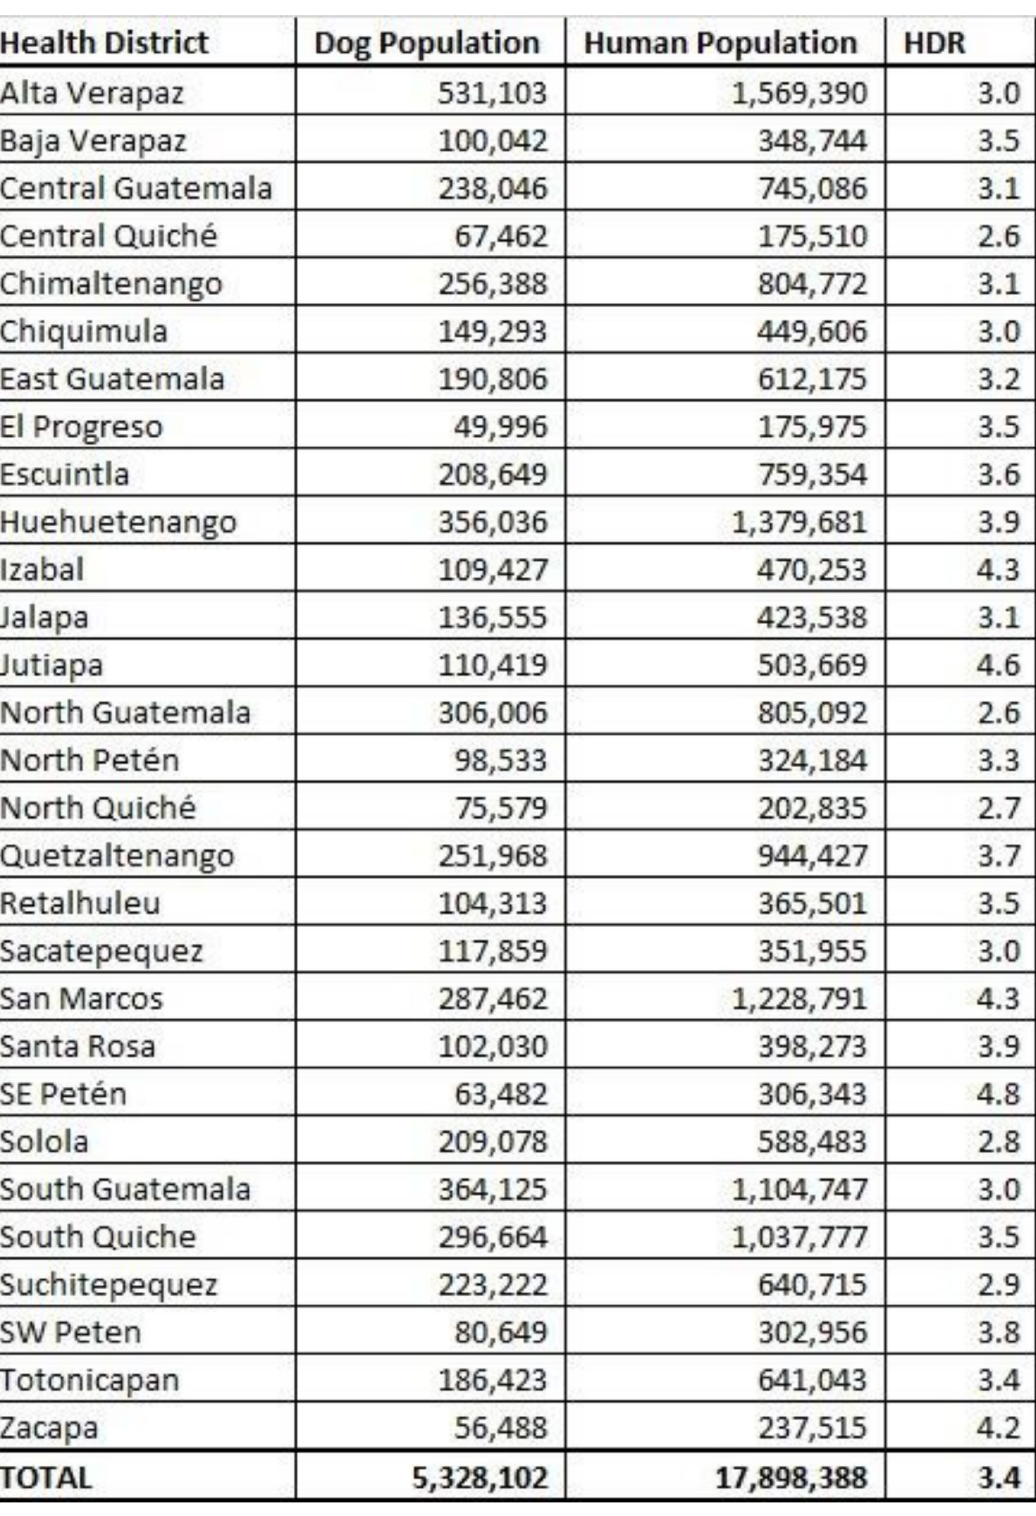
Fig 7. Projected HDR by Guatemala Health Areas based on the study results.